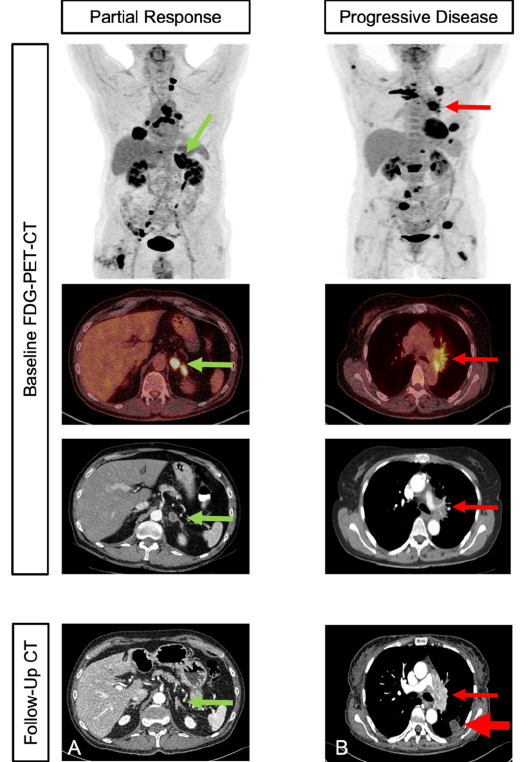
Figure 2. Initial staging and second follow-up in two patients with different response: Patient with adrenal (marked with green arrow), bone, and lymph node metastases in initial staging PET-CT. Partial response was shown in contrast-enhanced CT in second follow up ( A ). Patient with multiple intra-pulmonal (marked with red arrow) and bone metastases in initial staging PET-CT. Progressive disease was shown in contrast-enhanced CT in second follow up ( B ).